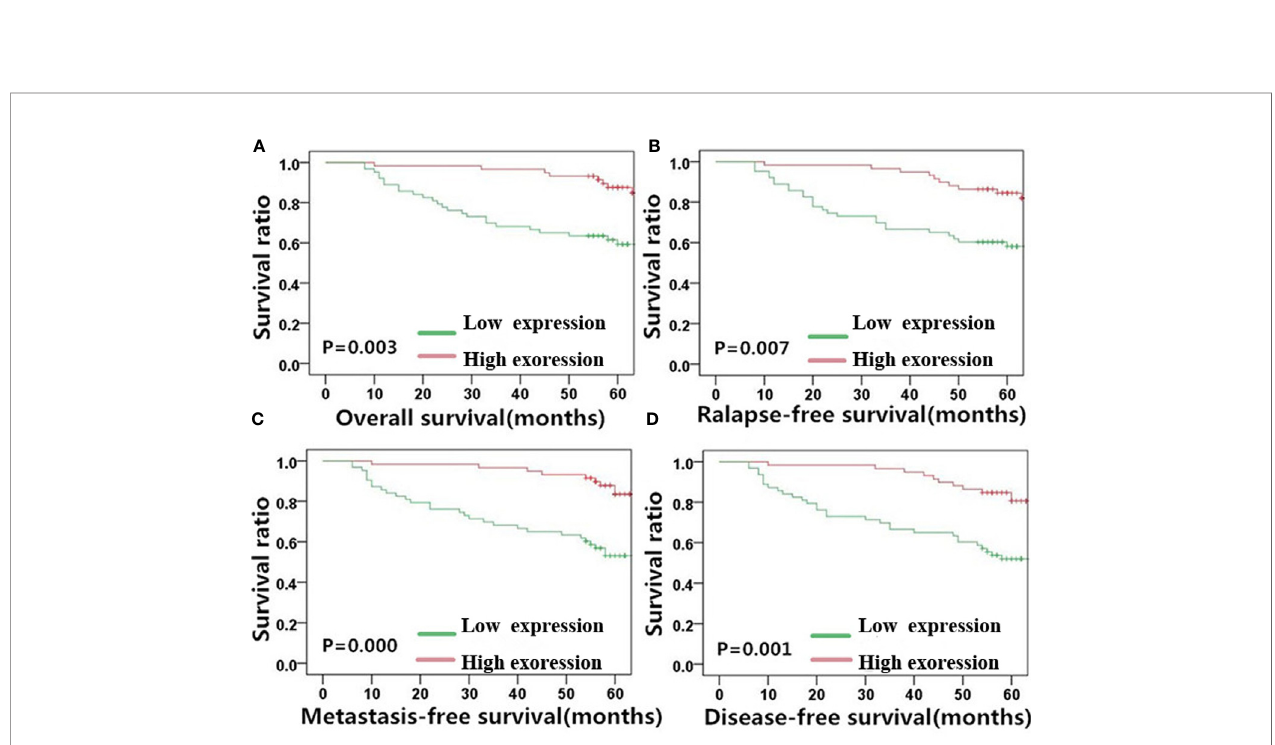
FIGURE 4 | E-cadherin expression is signi fi cantly correlated with NPC patient survival outcome. Kaplan-Meier survival plots for (A) overall survival, (B) relapse-free survival, (C) metastasis-free survival, and (D) disease-free survival of the high (red lines) and low (green lines) E-cadherin expression groups. NPC, nasopharyngeal